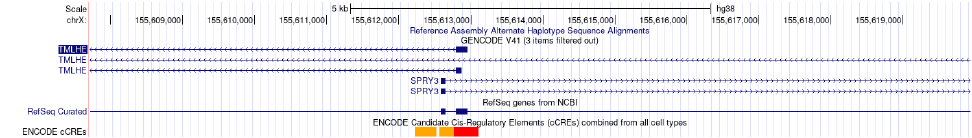
Figure 4. Genomic region of TMLHE and SPRY3 genes. In this case, the promoter signature (red) is an ambiguous position between the two divergent genes, and due to some overlapping, the prom peaks could be assigned to the wrong